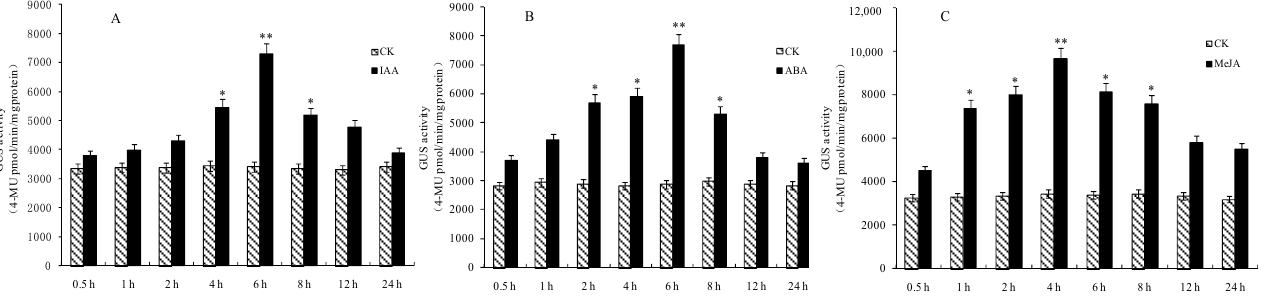
Figure 8. Determination of GUS activity in Arabidopsis thaliana with the full-length promoter of the GmRIQ2 gene transformed by hormone treatment. ( A ) IAA: 50 μ M; ( B ) ABA and ( C ) MeJA: 100 μ M. The data are shown as the mean ± SE of three independent replicates. * and ** indicate significant difference at 0.05 and 0.01 levels, respectively